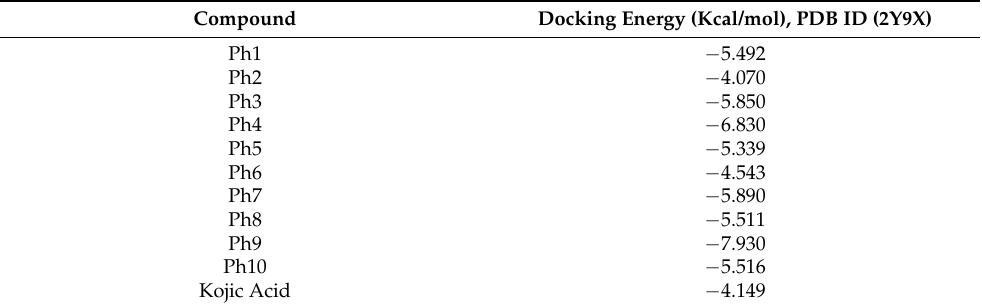
Table 3. Docking energies of synthesized amide derivatives (Ph1–Ph10) against mushroom tyrosinase, PDB ID